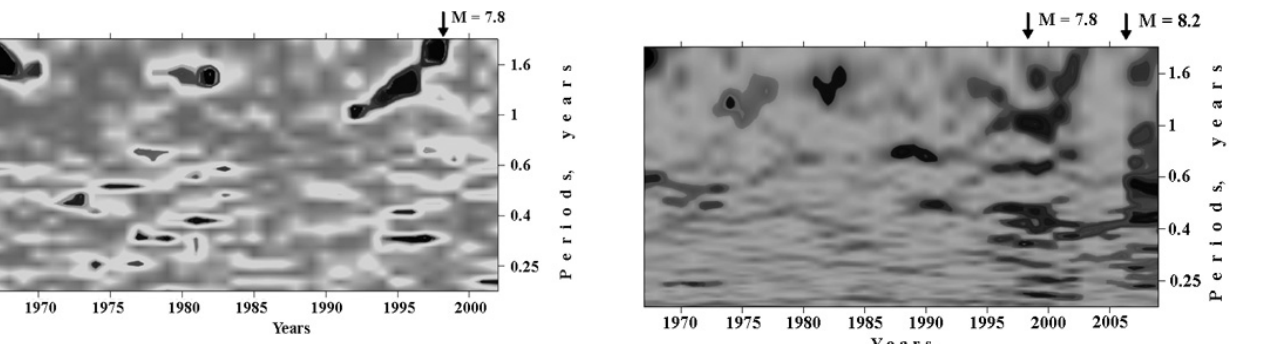
Fig. 14. Spectral-temporal diagram of the logarithmic likelihood function 1 ln L increments for the area with a radius of 50km for the region center of which shifted 100km away from the center of the aftershock zone for the Kronotskoe earthquake. The ordinates show the spectral periods. The occurrence times of the Kronotskoe earthquake of 5 December 1997 and the Simushirskoe earthquake of 15 November 2006 ( M = 8 . 2) are shown by the